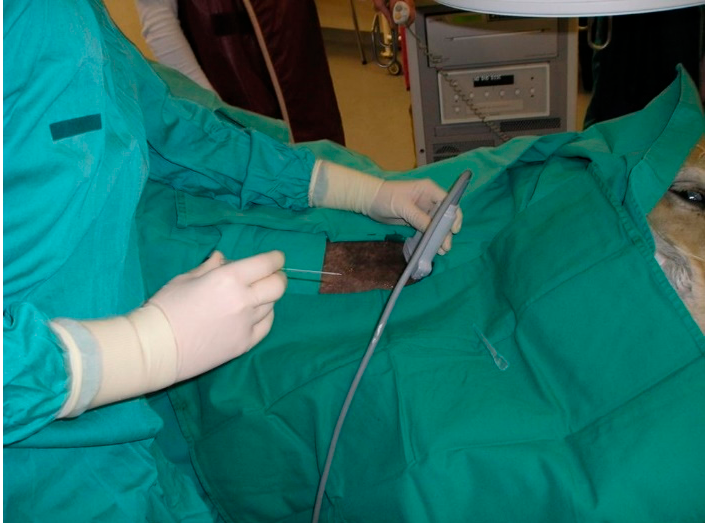
Figure 1. Percutaneous ultrasound-guided puncture to the right common carotid artery, with the horse under general anaesthesia in lateral recumbency. The ultrasound probe was previously immersed in disinfectant solution and rinsed with sterile wash water.